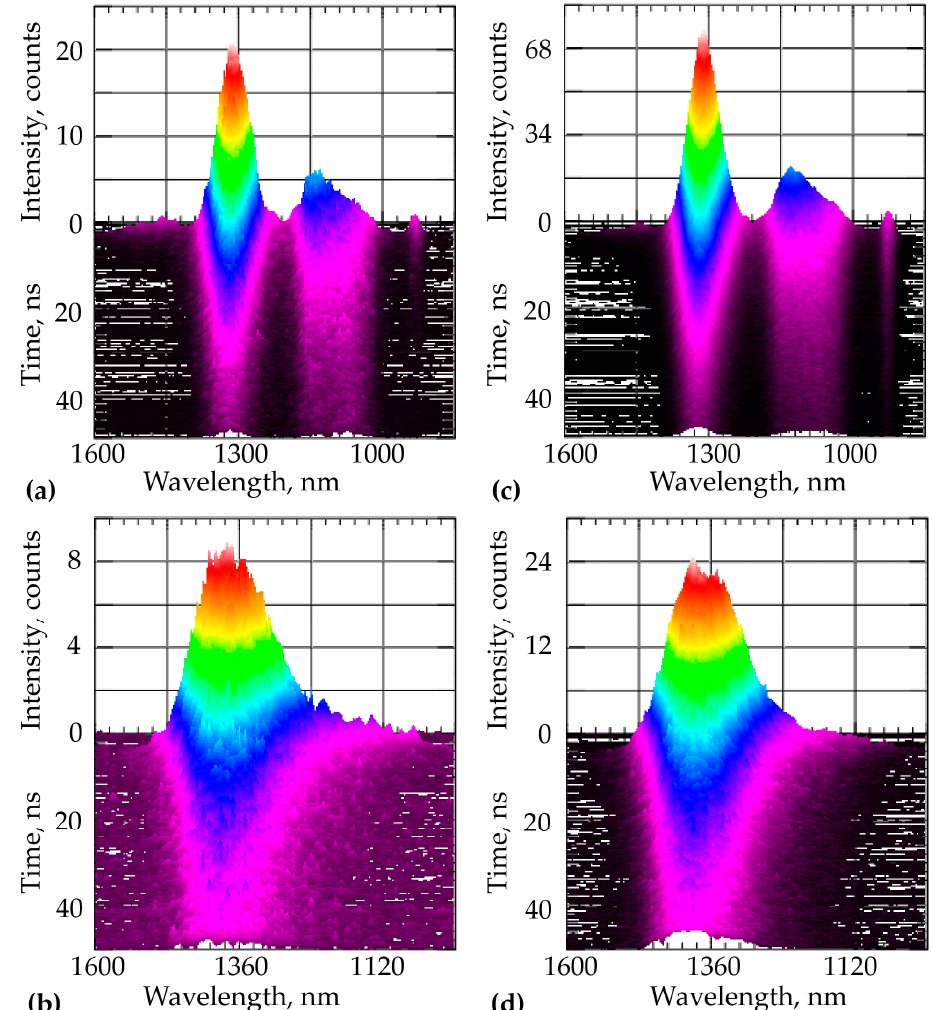
Figure 3. PL spectra of the heterostructures at 532 nm wavelength excitation: ( a ) nanowires (NWs) at T = 77 K; ( b ) NWs at T = 300 K; ( c ) NWs with the TOPO-CdSe/ZnS QDs layers at T = 77 K; and ( d ) NWs with the TOPO-CdSe/ZnS QDs layers at T = 300 K.